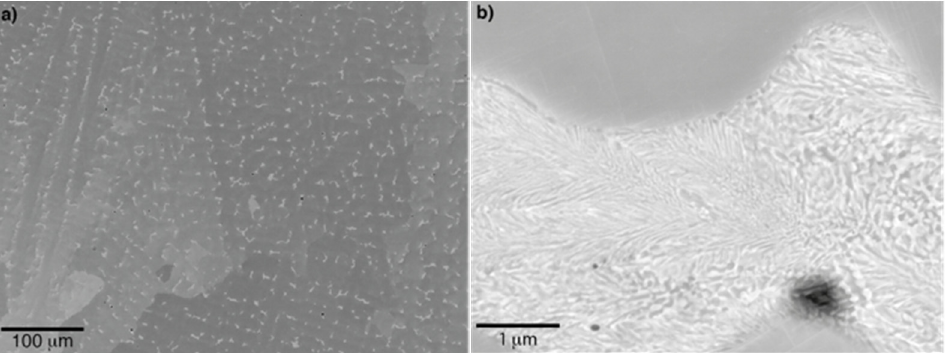
Figure 8. BSE micrographs of Stellite-21 in the as-cast state. ( a ) Low magnification image of the dendritic microstructure. ( b ) Higher magnification image of the interdendritic lamella intergrowth. Microstructural analysis of the interdendritic lamella intergrowth using STEM EDX revealed